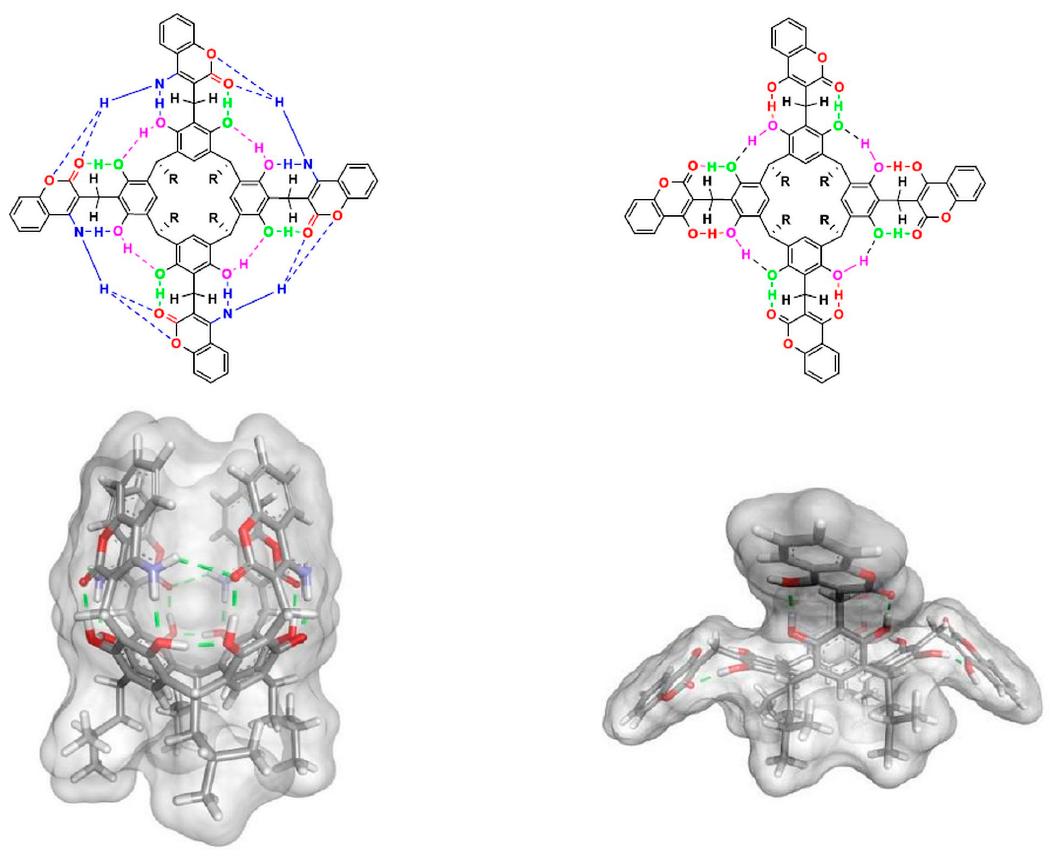
Figure 9. The crown- in conformation of the aminocoumarin derivative of resorcin[4]arene ( left ) and crown- out conformation of the hydroxycoumarin derivative of resorcin[4]arene ( right ) in CHCl 3 .